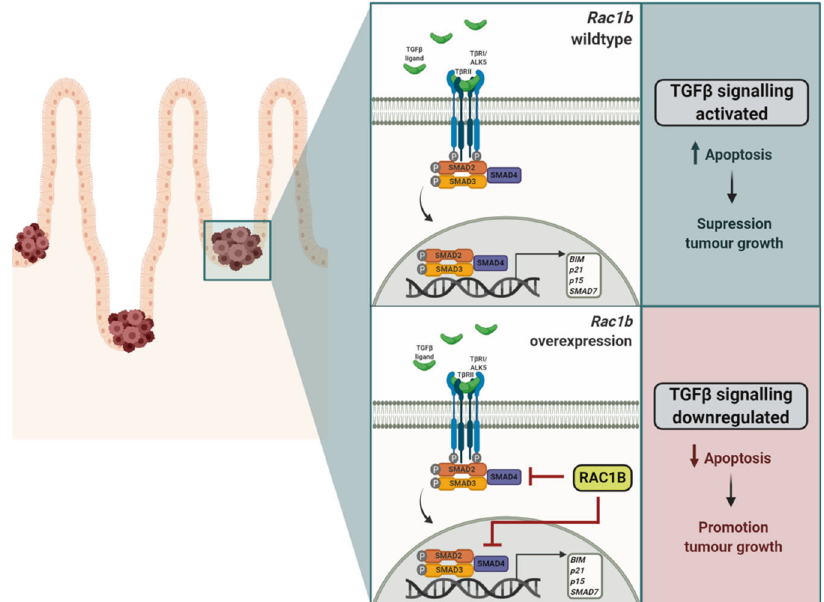
Fig. 7 Model of RAC1B negative regulation of TGF β signalling promoting tumour initiation. Schematic outlining of RAC1B function in our model: when pre-adenomatous lesions are formed in the small intestine under low/wild type levels of RAC1B expression, TGF β remains active and can induce apoptosis through transcription activation of its targeted genes such as BIM , CDKN1A and CDKN2B , leading to the suppression of tumour growth and favouring survival. However, in the context of high RAC1B levels, TGF β signalling activation is impaired, resulting in